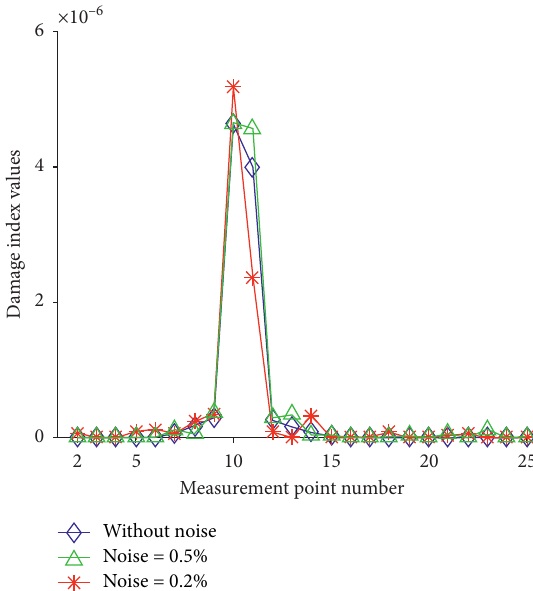
Figure 6: DI values of a simply supported beam with single damage. Table 4: Element stiffness reduction ratio.